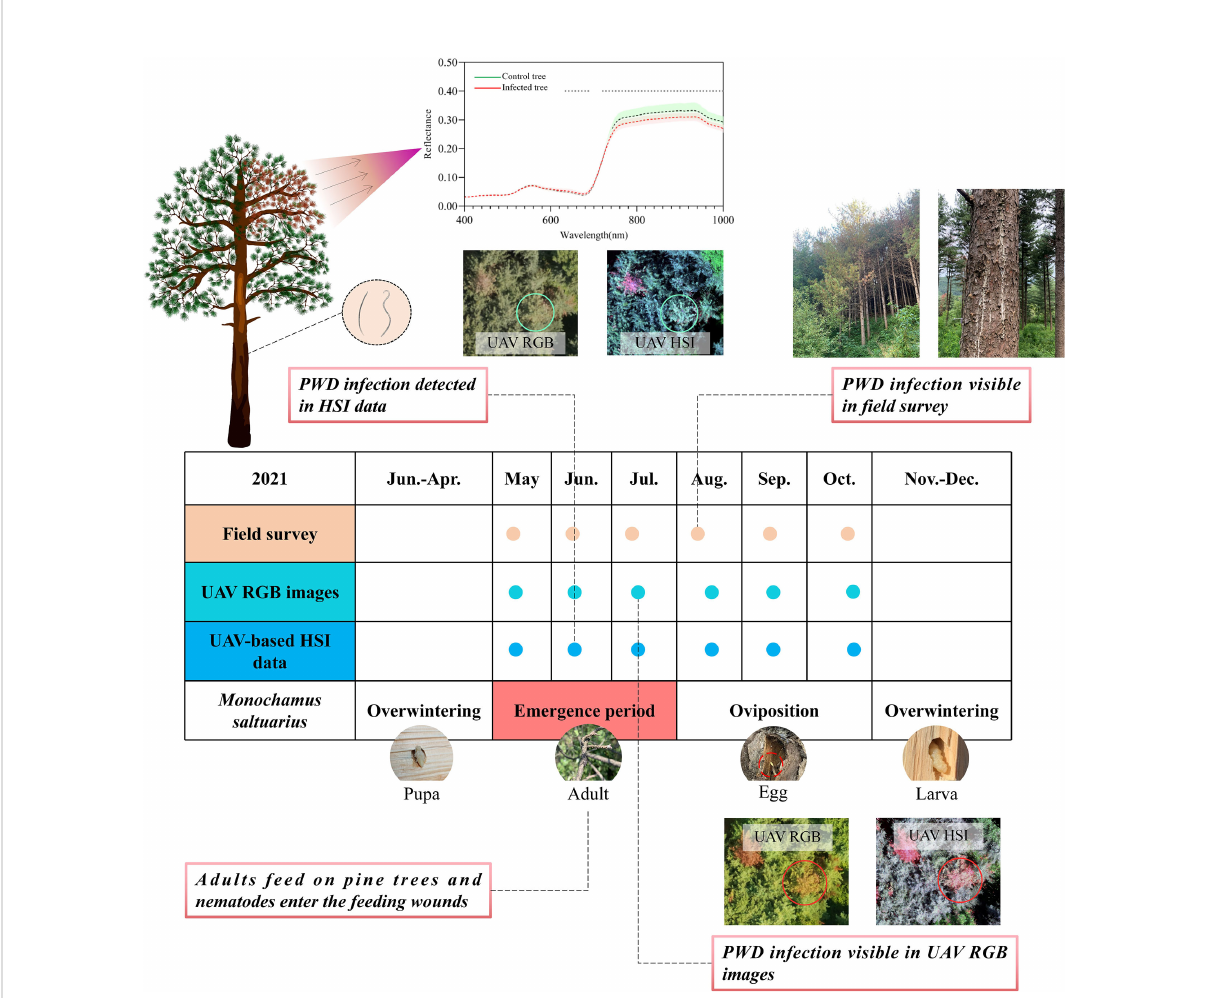
FIGURE 4 Overview of UAV-based RGB and hyperspectral data acquisitions and fi eld surveys. The dots indicate data collection dates: fi eld survey (pink), RGB images (blue-green), and hyperspectral data